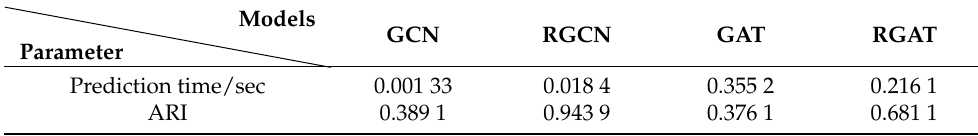
Table 4. Time complexity and clustering accuracy of the four studied